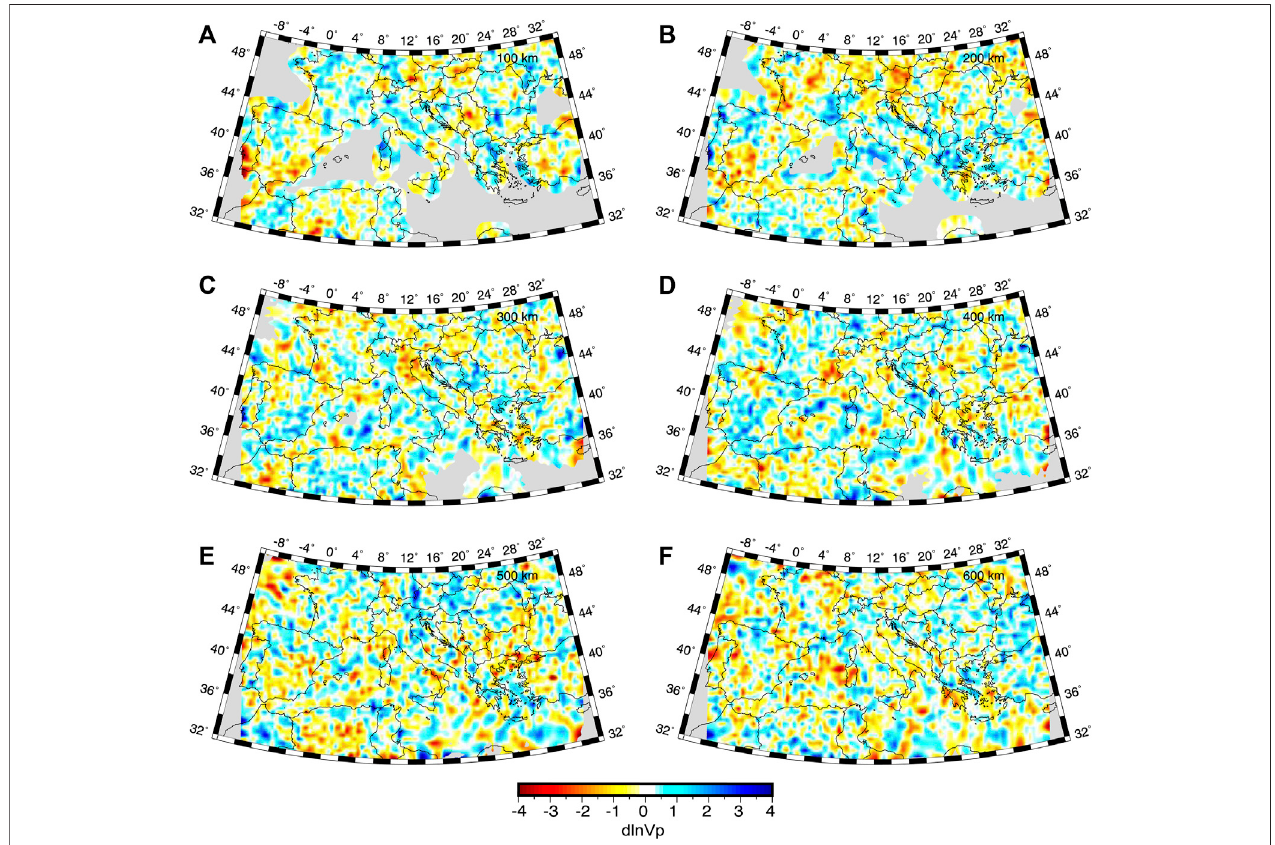
FIGURE 4 | Depth slices at (A) 100 km, (B) 200 km, (C) 300 Km, (D) 400 km, (E) 500 km and (F) 600 km depth. Permuted data test. P-wave velocity anomalies obtained from the inversion of randomly permuted delay times.